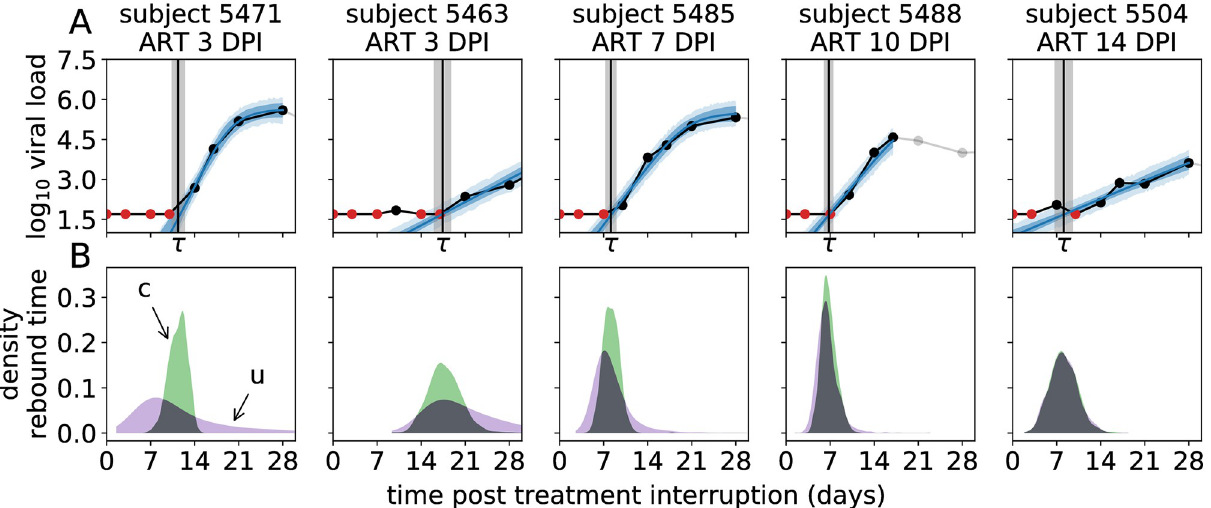
Fig 3. Representative examples of the fits of the mixed-effects modelto the VL rebound time series. (A) The top panels show the VL data (black dots connected by black lines, with red dots for left-censored observations; the grey dots are ignored) taken from macaques where ART was started at different days post infection (DPI), and the model prediction (blue lines: posterior mean; dark blue band: 50% credible interval (CrI), light blue band: 50% posterior predictive interval). The estimated time-to-rebound ( τ ) is given by the vertical black line (gray band: 50% CrI). (B) The bottom panels show posterior predictive distributions of the time-to-rebound. The green distributions (c) are conditioned on the estimated time of the initial recrudescence event, the purple distributions (u) are unconditional. Model fits and posterior predictive distributions for all 25 macaques are shown in S1 Fig.